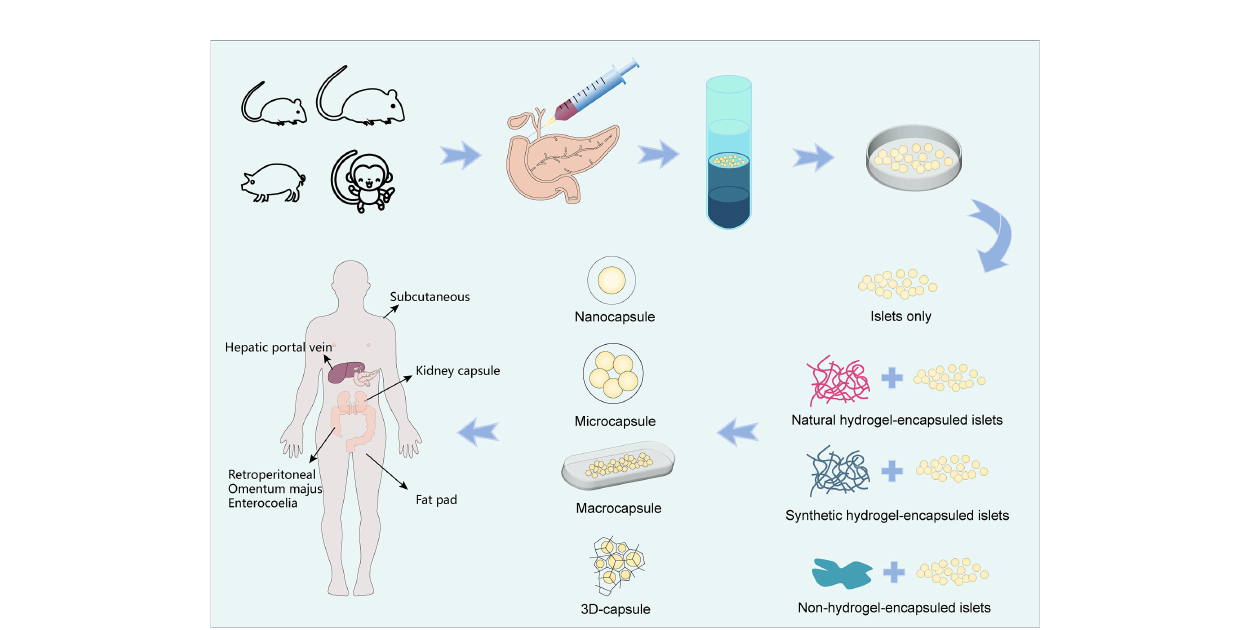
FIGURE 1 | Flow chart of islet encapsulation and transplantation. There are many sources of islet cells, such as mice, rats, porcines and monkeys, etc. We injected collagenase into pancreas and isolated islets by density gradient centrifugation after pancreatic fi lling. The islets are capsuled with natural hydrogels, synthetic hydrogels and other types of hydrogels, forming capsules of different sizes (Nanocapsule, Microcapsule, Macrocapsule and 3D-capsule) and then transplanted. Common sites of transplantation are subcutaneous, kidney capsule, hepatic portal vein, retroperitoneal, omentum majus, enterocoelia, fat pad,